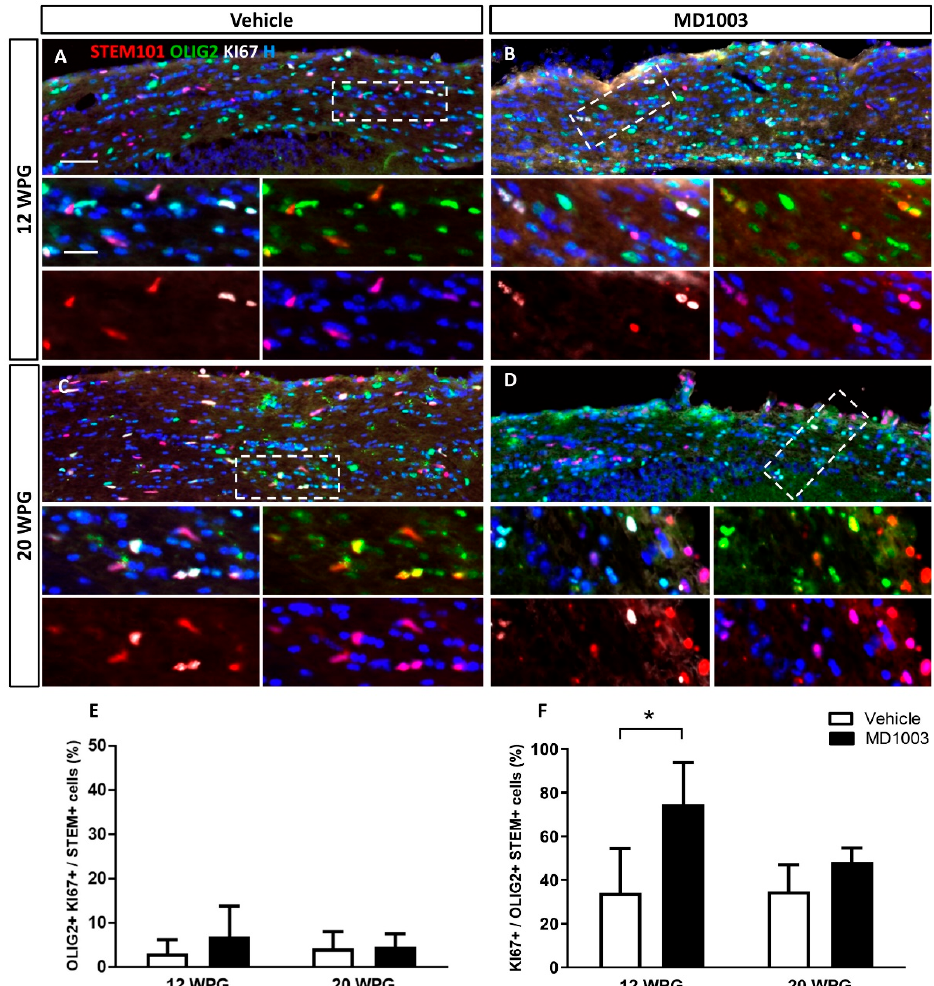
Figure 5. MD1003 increases the percentage of proliferating human oligodendroglial cells. ( A – D ) Immunohistochemistry for STEM101+ human cells (red), OLIG2+ oligodendroglia (green) and KI67+ proliferating cell (white) are shown for all the grafted animals at 12 wpg and 20 wpg, treated with vehicle or MD1003. Insets show higher magnification of white dotted boxes in ( A – D ). ( E ) The percentage of OLIG2+KI67+ proliferating human cells tends to slightly increase (not significant) in MD1003-treated group at 12 wpg. ( F ) MD1003 significantly increases the percentage of STEM+OLIG2+KI67+ proliferating human oligodendroglia over OLIG2+STEM+ human oligodendroglia. Two-way ANOVA followed by Tukey’s multiple comparison test ( n : 3–6 per groups). * p < 0.05. Error bars represent SEMs. WPG: weeks post graft, scale bar in ( A – D ): 50 µm and in the insets: 20 µm.